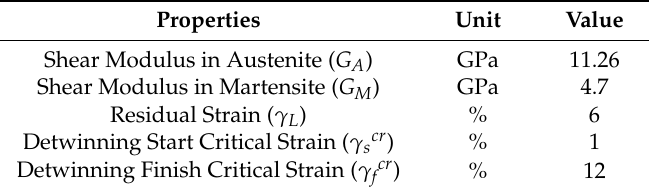
Table 2. Material properties of SMA.